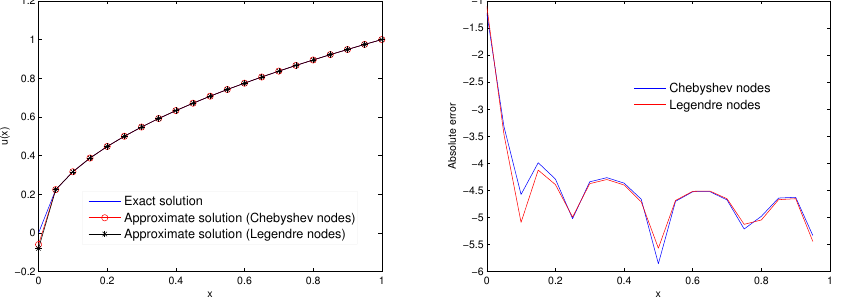
Figure 5. Plot of the exact and approximate solutions ( left ) and absolute error ( right ) taking r = 7 and β = µ = 1/3 at Chebyshev and Legendre nodes for Example